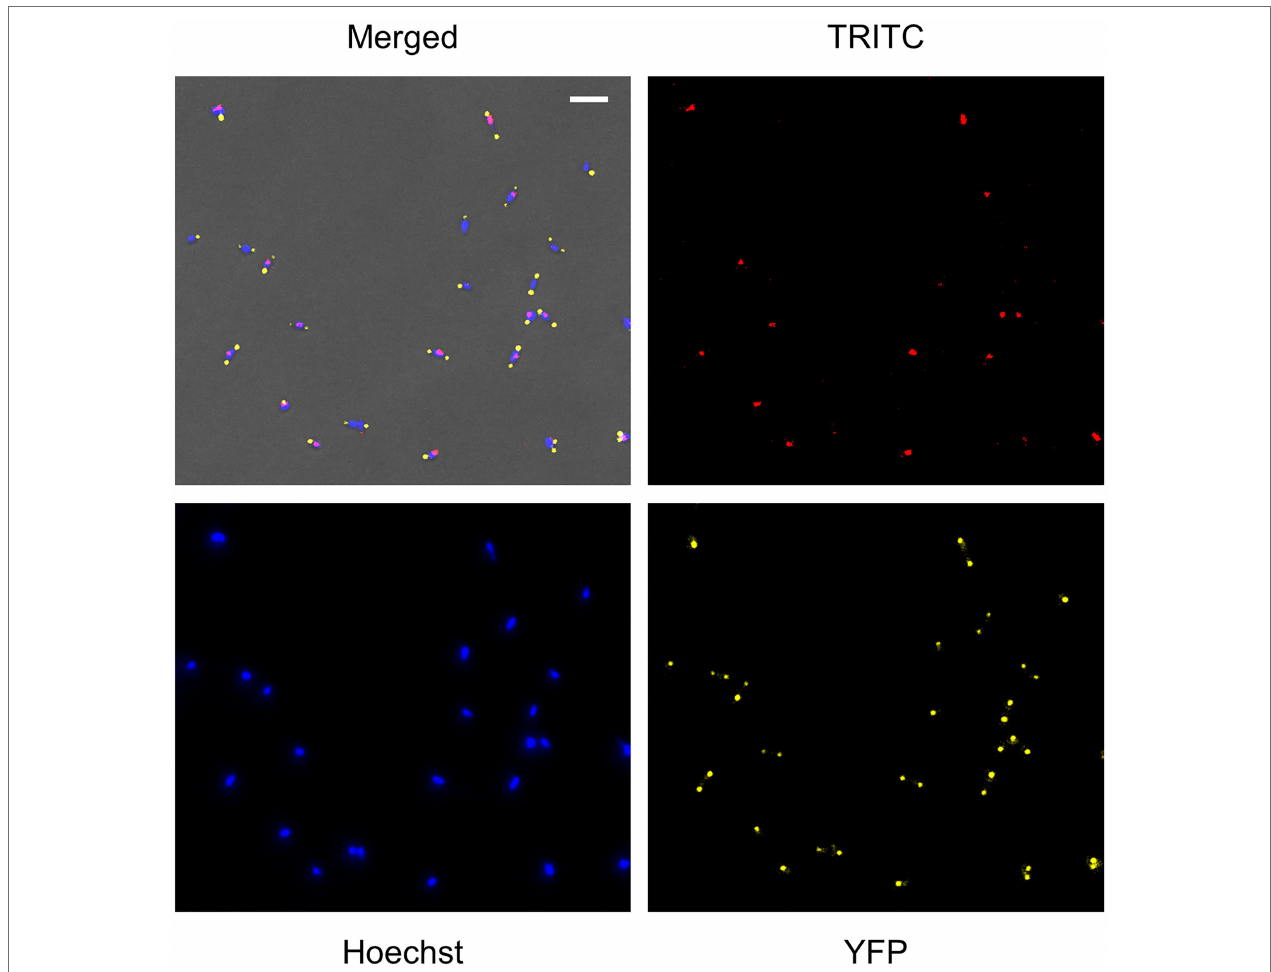
FIGURE 6 | Single cell analysis of FtsZ, P65, and chromosome localization in the mraZ mutant. Fluorescence microscopy analysis showing FtsZ-mCherry, P65-eYFP, and chromosome localization in live cells of M. genitalium . Each panel shows the TRITC, 4 ' ,6-diamidino-2-phenylindole (DAPI), and eYFP images or a combination of the three channels and the phase contrast. The scale bar represents 2 μ m. All images are shown at the same